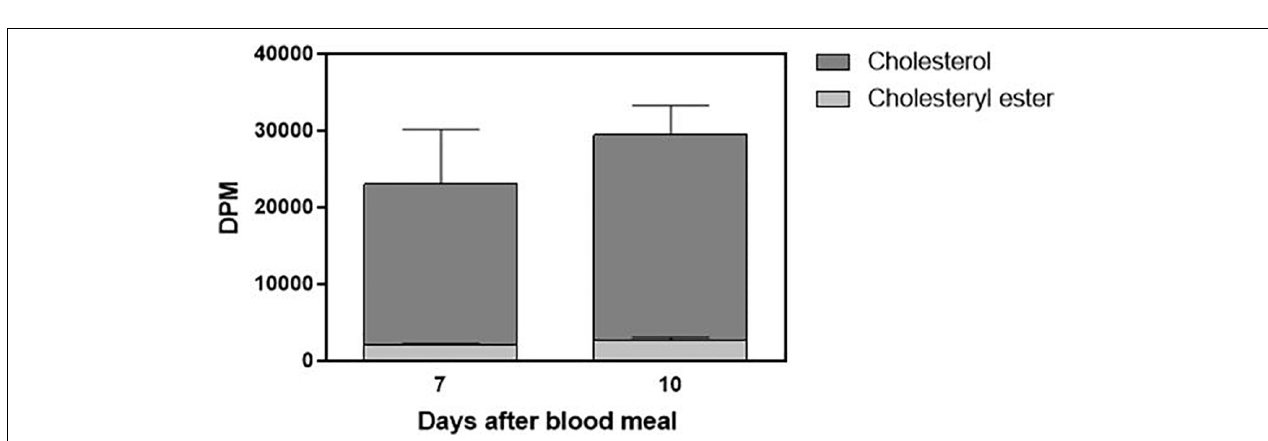
FIGURE 4 | The fat body and ovary incorporate cholesterol from the blood meal. Rhodnius prolixus adult females were fed on 3 H-cholesterol-enriched blood and dissected on different days after the blood meal. Total lipids from the fat body (A) or ovaries (B) were extracted and were analyzed by HPTLC. Radioactivity associated with free cholesterol (dark bars) and esterified cholesterol (light bars) was quantified and expressed as DPM/organ ± SEM for three to four determinations. (*) and (***): significantly different from 1 day after analysis by one-way ANOVA followed by Dunnett’s posttest, p < 0.05 and p < 0.001, respectively. HPTLC, high-performance thin-layer chromatography; DPM, disintegrations per minute.